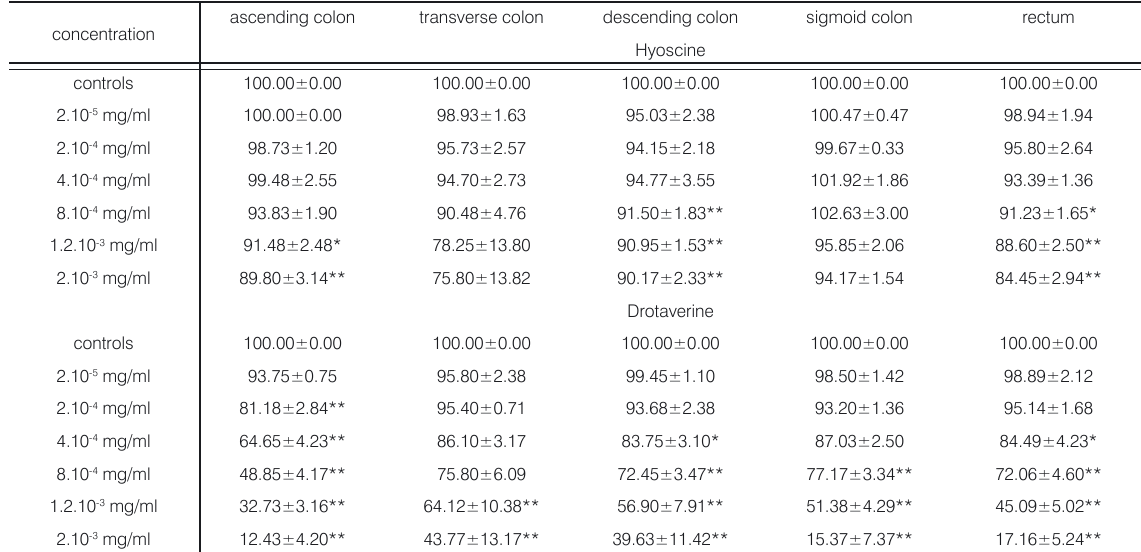
Table 2. Influence of hyoscine and drotaverine on the frequency of spontaneous contractions of SM preparations from ascending colon, transverse colon, descending colon, sigmoid colon and rectum. The comparisons were made with reference to the initial values of the